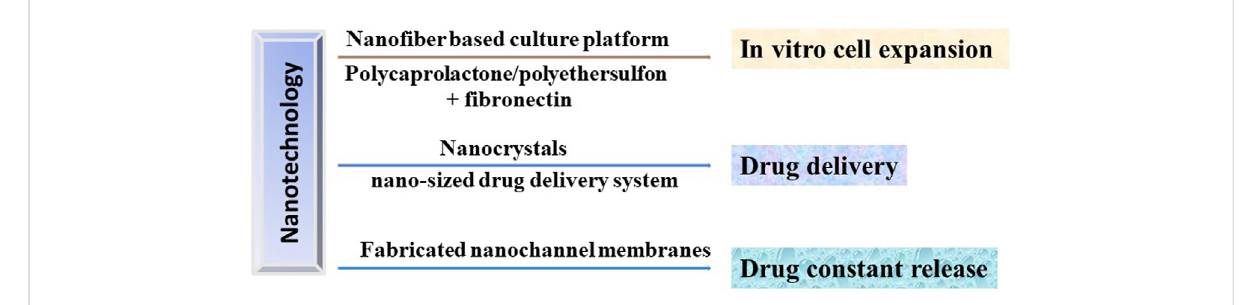
FIGURE 3 Potential applications of nanotechnology in HSCT in treating DOCK8 de fi ciency diseases. Nanotechnology could be used to produce the invitro culturingplatformstoexpandtheHSCwithhighef fi ciency,thedrugdeliveryandreleasesystemtopreciselydelivertheimmunosuppressants to desired therapeutic area and to achieve constant release of drugs,